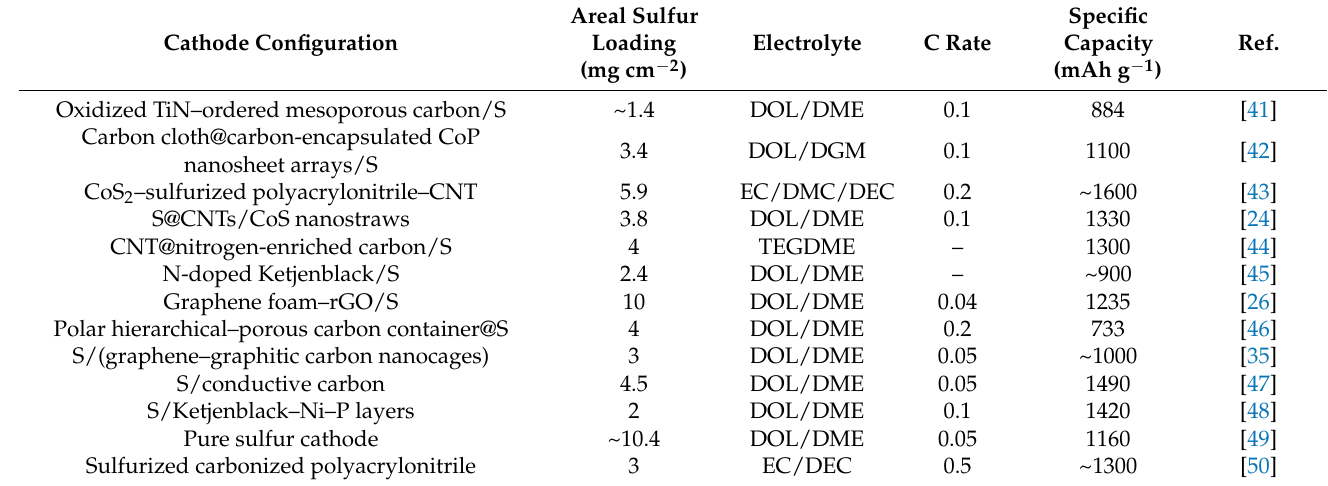
Table 2. Summary of Li–S pouch cells 1 fabricated with different cathode